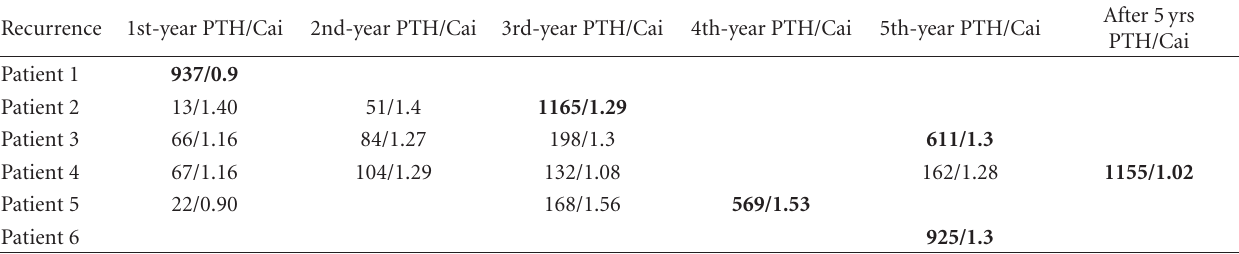
Table 3: Patients followup with graft-dependent recurrence years after